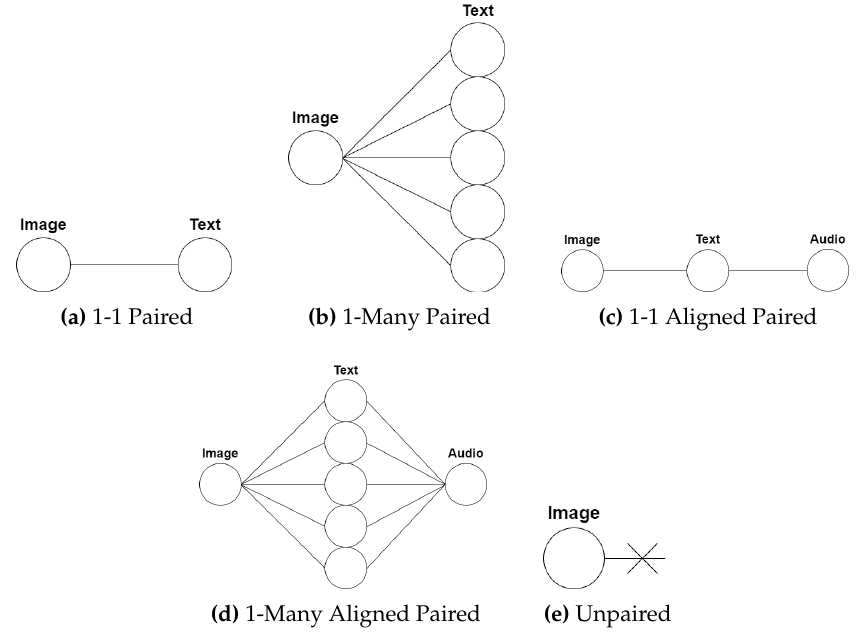
Figure 1. The various pairwise relationships present in information retrieval datasets. ( a ) 1-1 Paired, ( b ) 1-1 Many Paired, ( c ) 1-1 Aligned Paired, ( d ) 1-Many Aligned Paired, and ( e )